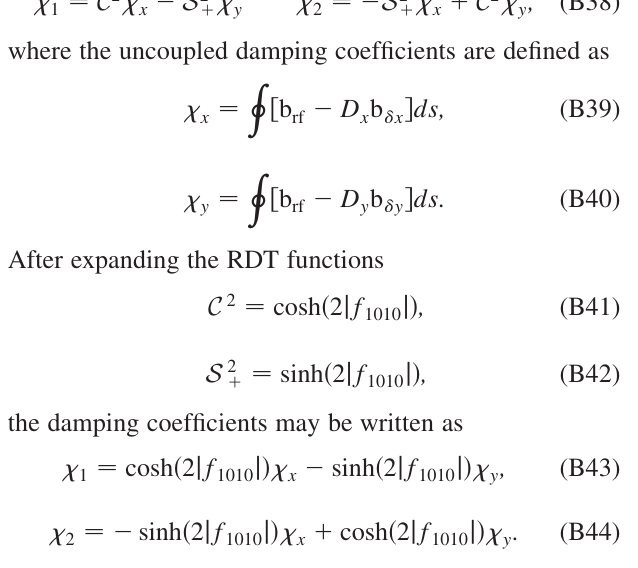
FIG. 12. Comparison between the vertical eigenemittance E computed by MADX (blue diamonds) and via Eqs. (26) and (27) (red plus) of Table III.